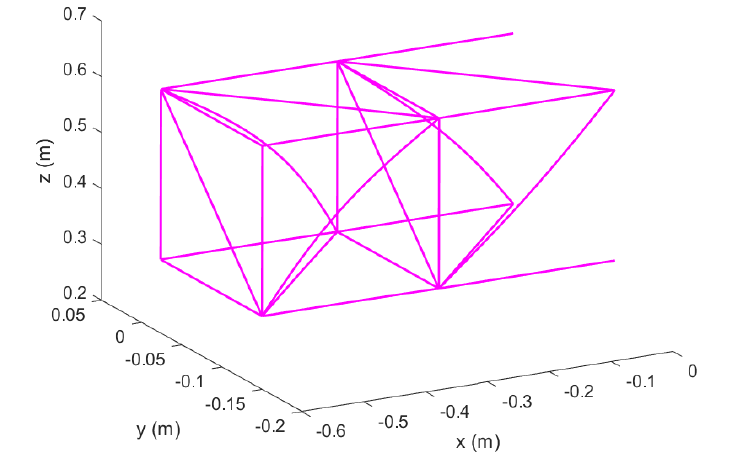
Figure 35. Mode 3 of Timoshenko beams in Topology 1 with hinged ends; spanwise expanded